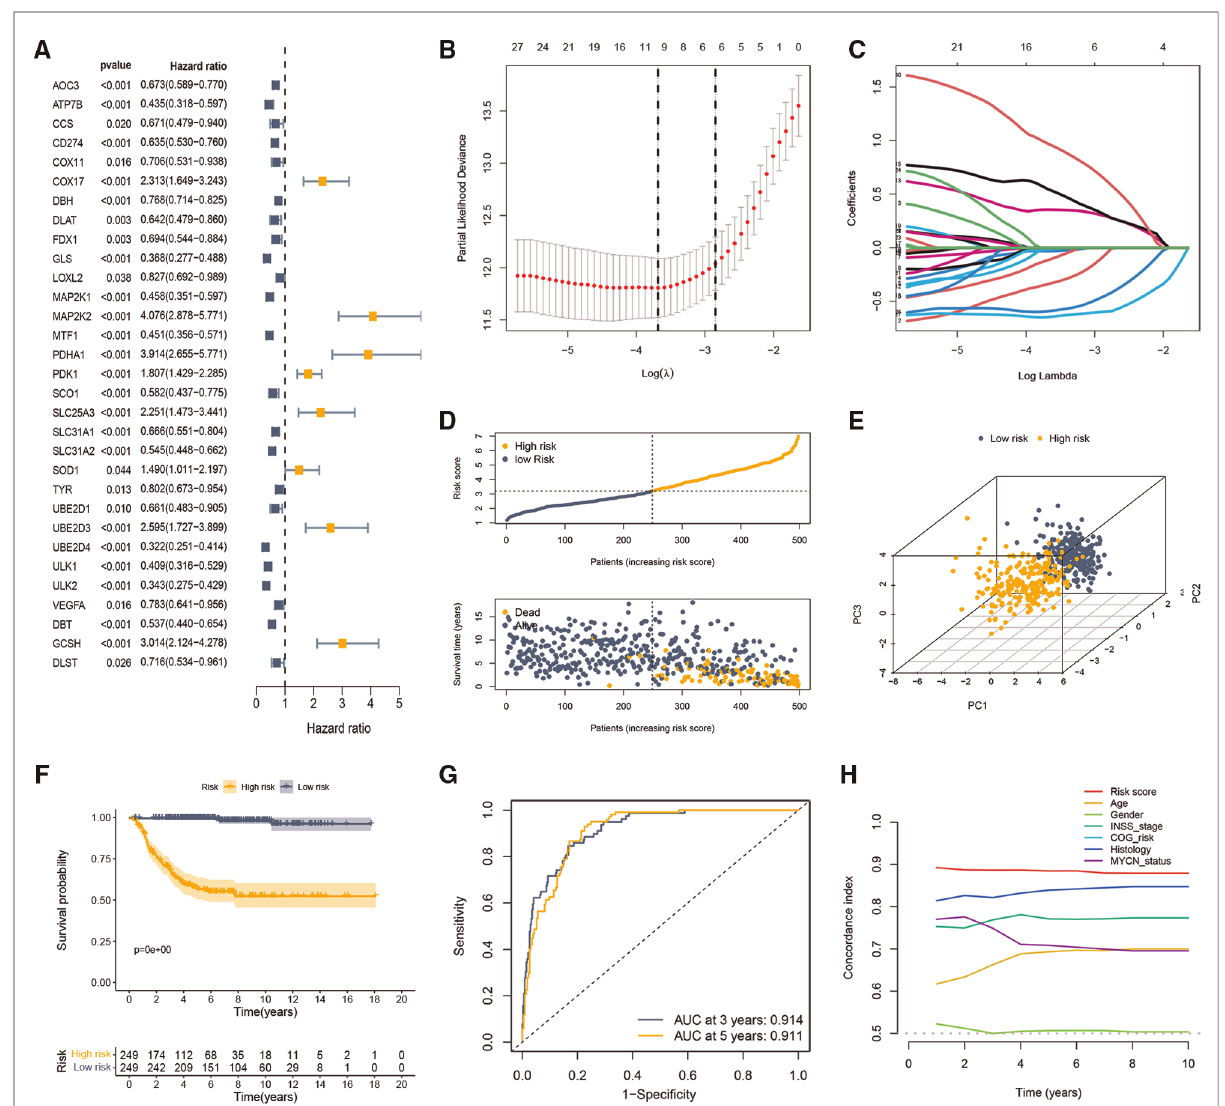
FIGURE 1 Development of the cuproptosis-related prognostic signature in the training set. ( A ) Forest plot of nine CRGs correlated with OS. ( B,C ) The LASSO Cox regression analysis was performed depending on the optimal λ value. ( D ) The distributions of OS status and patient survival status in the training set. ( E ) PCA showed remarkable differences between the two CRG-score groups. ( F ) The Kaplan-Meier curves showed that signi fi cant differences were identi fi ed for OS between these two risk groups. ( G ) ROC curves evaluating the sensitivity and speci fi city of the cuproptosis-based prognostic model. ( H ) C-index of the risk score and other clinical